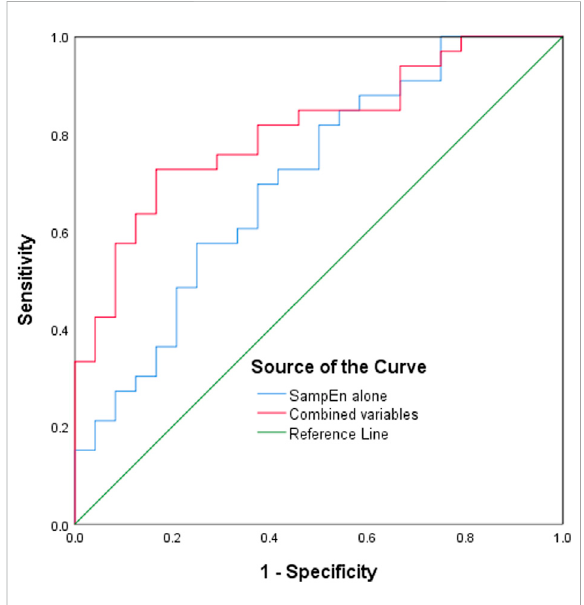
FIGURE 2 Receiver operating characteristic curves of the SampEn value of rSO 2 signal to predict POCI. SampEn, sample entropy; rSO 2 , regional cerebral oxygen saturation; POCI, postoperative cognitive